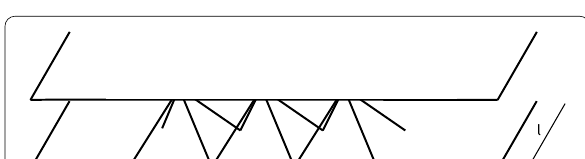
Figure 8 Final test set‑up for peel tests